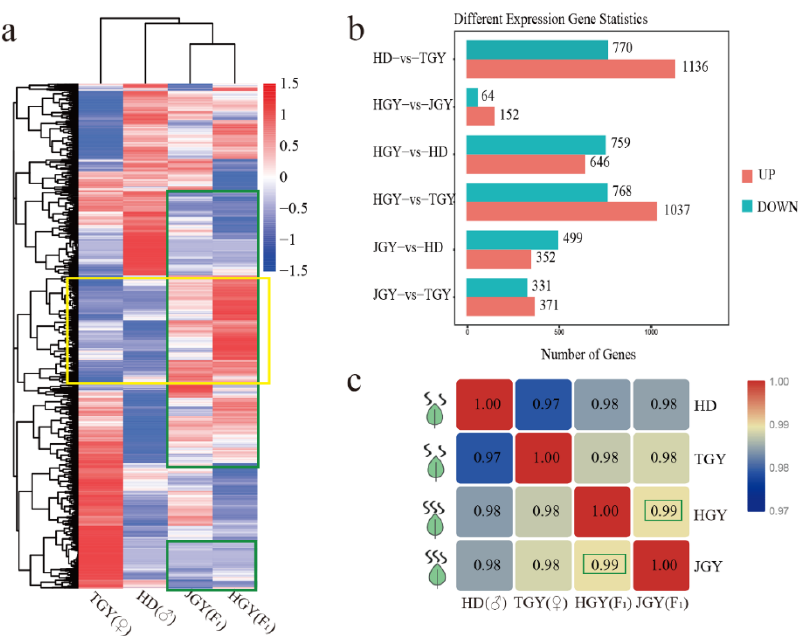
Figure 1. Comparative analysis of the expressed genes detected in two F1 hybrid and parental lines. ( a ) Heat map of DEGs from four different tea cultivar. Clustering by relative expression level value log2 (ratios) of differential genes. Similarly expressed genes between two F1 hybrids were boxed by green and higher expressed genes than parental were boxed by yellow. Red indicates high expression and green indicates low expression ( b ). Differentially expressed genes between different tea varieties at level of p > 0.05 and fold change ≥2. ( c ). Correlation matrix of two hybrids and their parents calculated by all the detected genes, two F1 hybrids correlation coefficient were boxed.